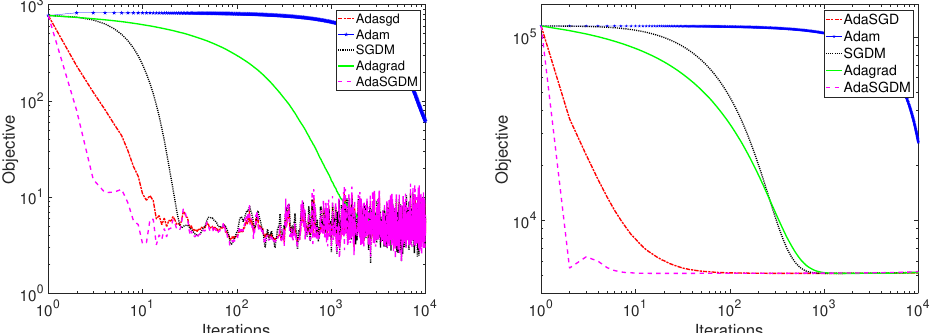
Figure 4. The convergence paths of the algorithms SGDM, Adam, and Adagrad and the proposed methods AdaSGD and AdaSGDM when m = 10,000, n = 200, and the objective functions are smooth non-convex functions. Left : the objective function f 3 ( x ) ; Right : the objective function f 4 ( x )